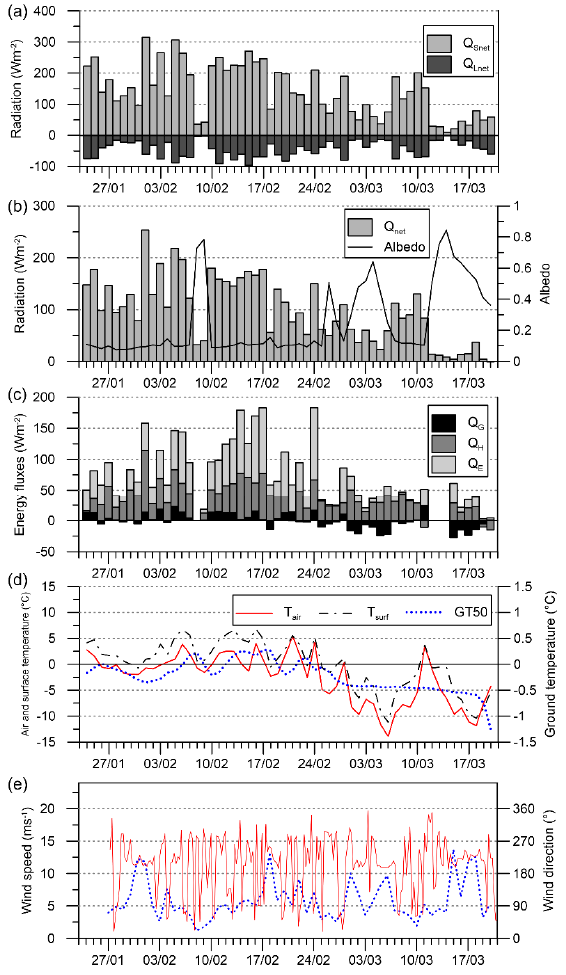
Figure 2. Daily averages of ( a ) net shortwave radiation (Q Snet ), net longwave radiation (Q Lnet ), ( b ) net radiation (Q net ) and albedo, ( c ) ground heat flux (Q G ), sensible heat flux (Q H ) and latent heat flux (Q E ), ( d ) air temperature (T air ), ground surface temperature (T surf ) and ground temperature at depth of 50 cm (GT 50 ), ( e ) wind speed (WS) and wind direction (as six-hourly immediate values, WD). Note that latent heat flux was calculated.